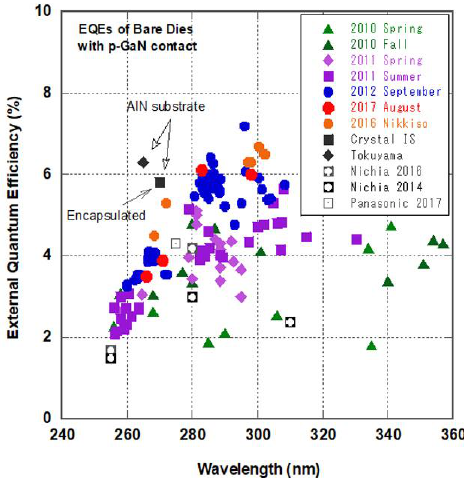
Figure 1. EQE mapping of AlGaN-based LED dies with p-GaN contact layer. The data are mainly for LED dies on planar sapphire from our group (colored). EQEs of LED dies from elsewhere (uncolored) using AlN substrates [17,18] and sapphire substrates [19–21] with a p-GaN contact layer are also shown. Solid uncolored symbols indicate the use of an AlN bulk substrate, where “ ■ ” indicates with encapsulation [17] and “ ◆ ” indicates no encapsulation. The EQEs in the case of an AlN substrate (“ ■ ” and “ ◆ ”) were achieved with a roughened light extraction surface. Uncolored open marks represent LED dies with p-GaN layer fabricated on planar sapphire reported by other groups. All of our data (colored) were obtained without boosting light extraction efficiency (LEE) using encapsulation [14,15,17] or a sapphire lens [21].